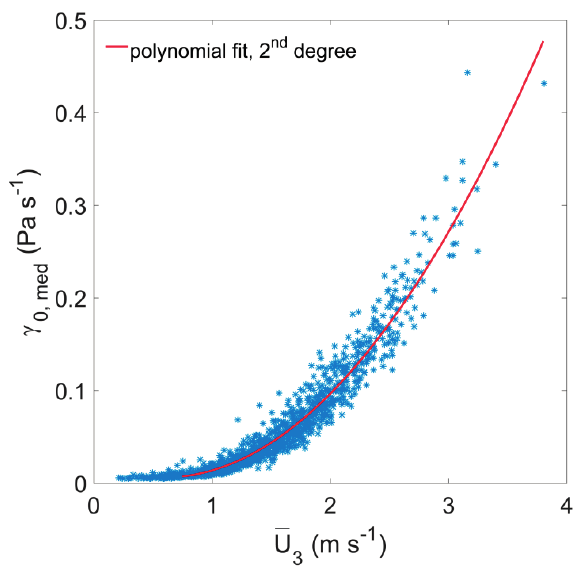
Figure 7. Dependence of the pressure-pumping coefficient calculated for the medium-frequency range at height (cid:1878) (cid:2868) ( (cid:2011) (cid:2868),(cid:2923)(cid:2915)(cid:2914) ) on mean above-canopy wind speed ( (cid:1847) (cid:3365) (cid:2871) ). In contrast, the pressure-pumping coefficient calculated for the low-frequency range (cid:2011) (cid:2868),(cid:2922)(cid:2925)(cid:2933) remained relatively constant, varying between 0.008 ± 0.004 Pa·s − 1 at (cid:1847)(cid:3365) (cid:2871) < 0.5 m·s − 1 and 0.030 ± 0.012 Pa·s − 1 at (cid:1847)(cid:3365) (cid:2871) > 2.5 m·s − 1 . The pressure-pumping coefficient for the high-frequency range (cid:2011) (cid:2868),(cid:2918)(cid:2919)(cid:2917)(cid:2918) also stayed constant with (cid:1847)(cid:3365) (cid:2871) , but was on average 4.5 times larger than (cid:2011) (cid:2868),(cid:2922)(cid:2925)(cid:2933) . It varied between 0.042 ± 0.004 Pa·s − 1 at (cid:1847)(cid:3365) (cid:1847)(cid:3365) (cid:2011) (cid:2871) < 0.5 m·s − 1 and 0.070 ± 0.010 Pa·s − 1 at (cid:2871) > 2.5 m·s − 1 . Therefore, (cid:2868),(cid:2923)(cid:2915)(cid:2914) is by far the most